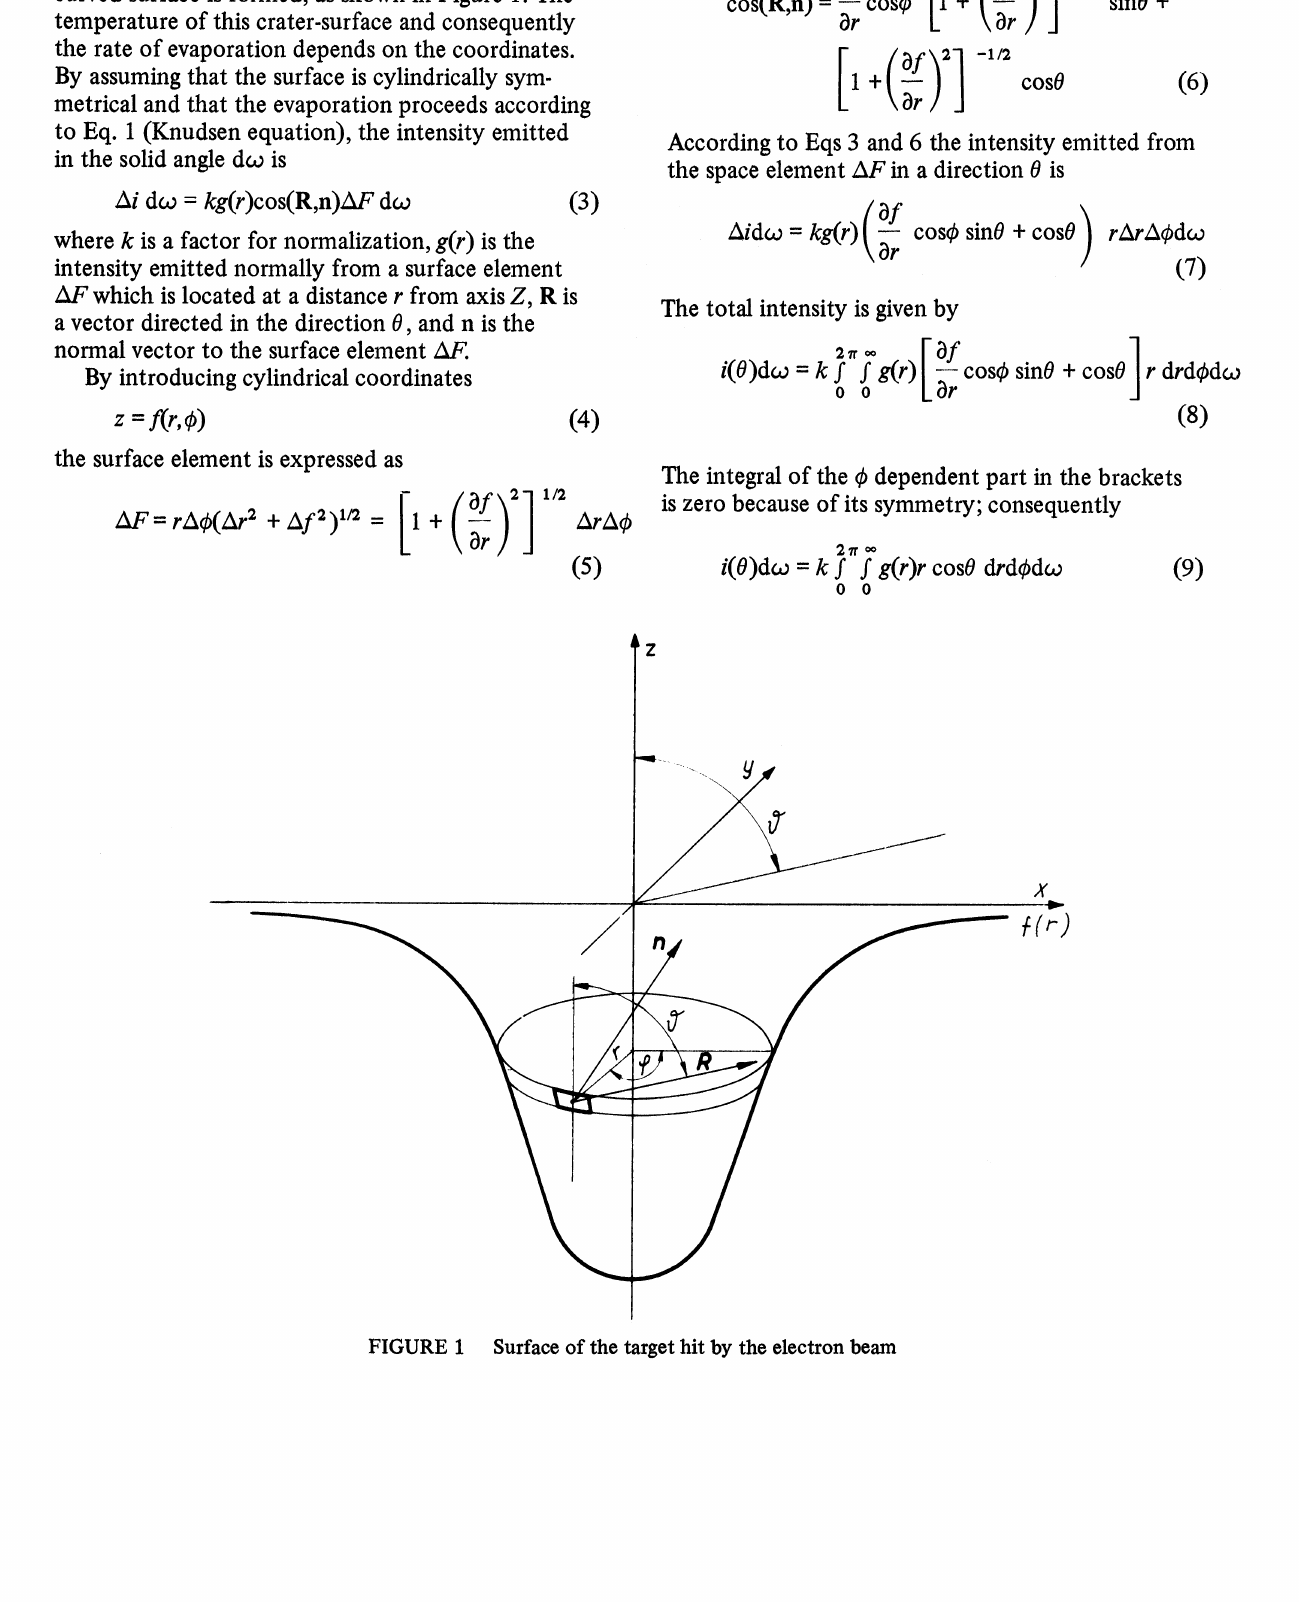
FIGURE 1 Surface of the target hit by the electron